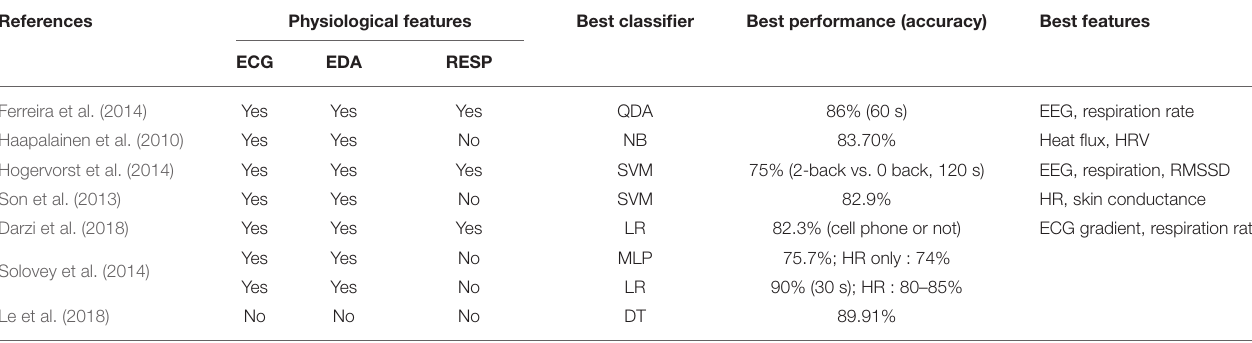
TABLE 1 | Summary of state of the